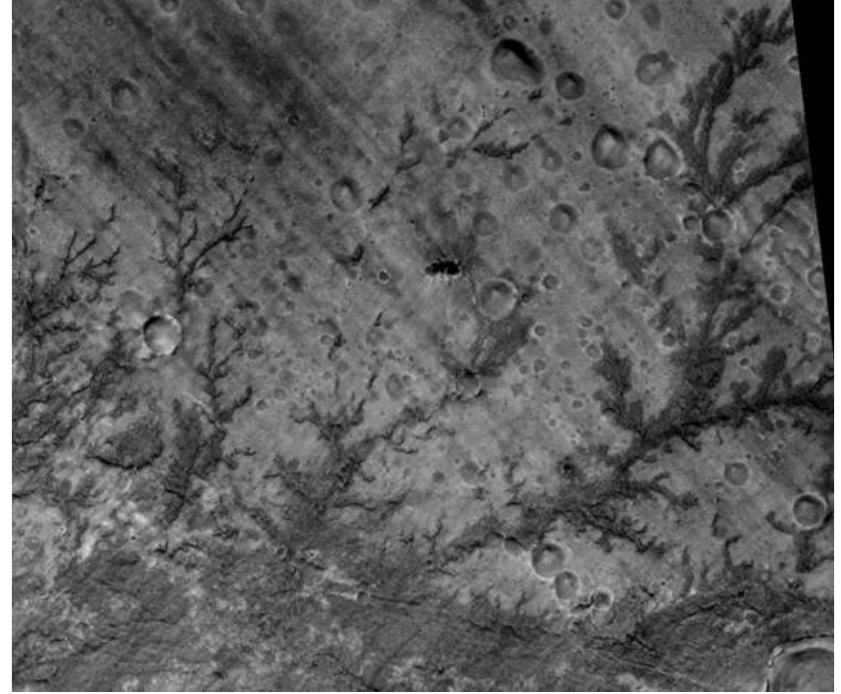
Figure 3. Inverted stream channels in Antoniadi Crater. Location is Syrtis Major quadrangle.